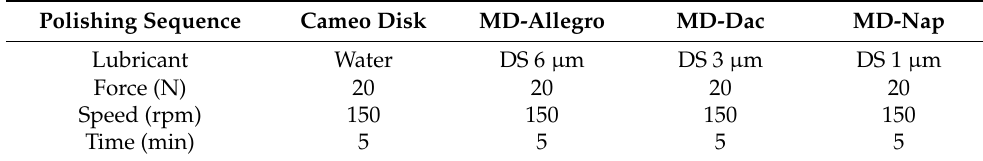
Table 1. Sample preparation